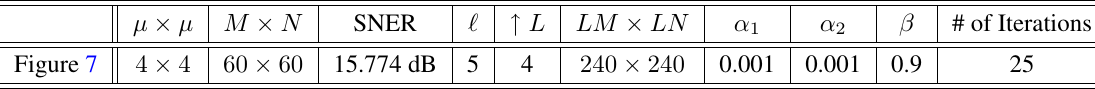
Table 4. Input parameters for real captured TOMBO images, D = 4